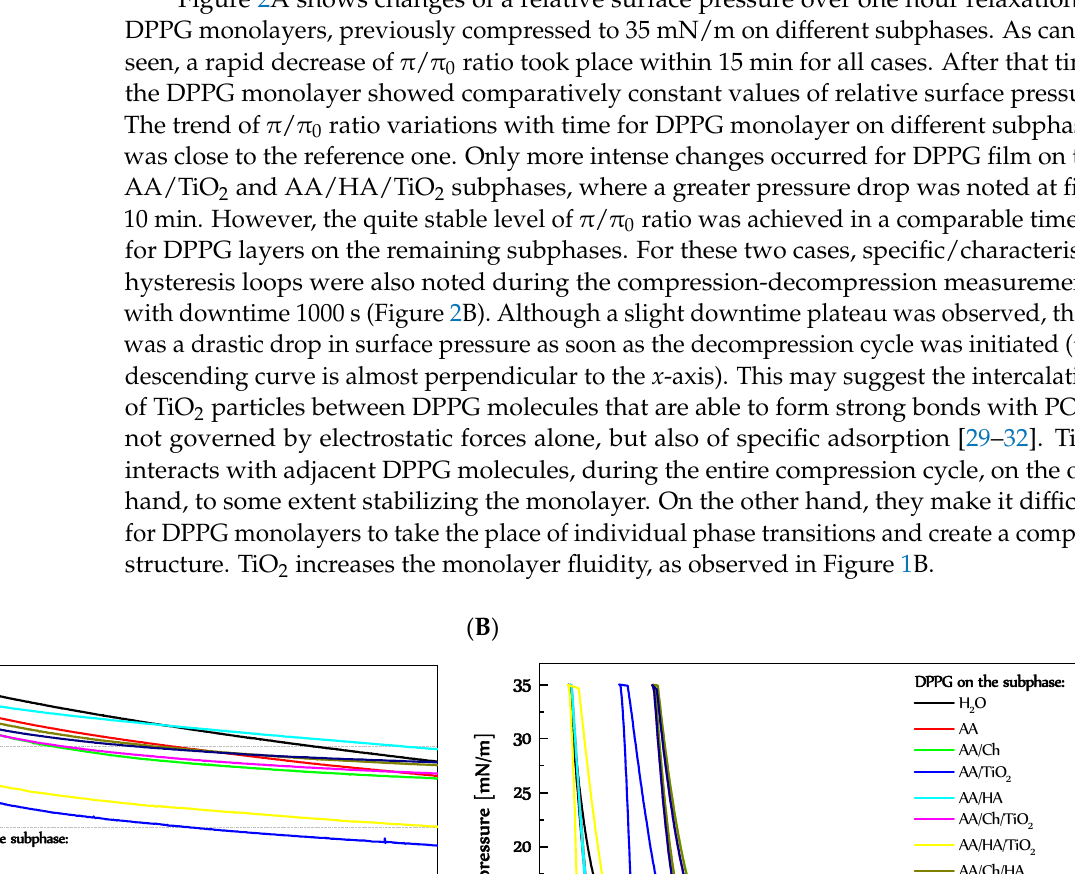
Table 2. Thickness of the DPPG monolayers during compression.